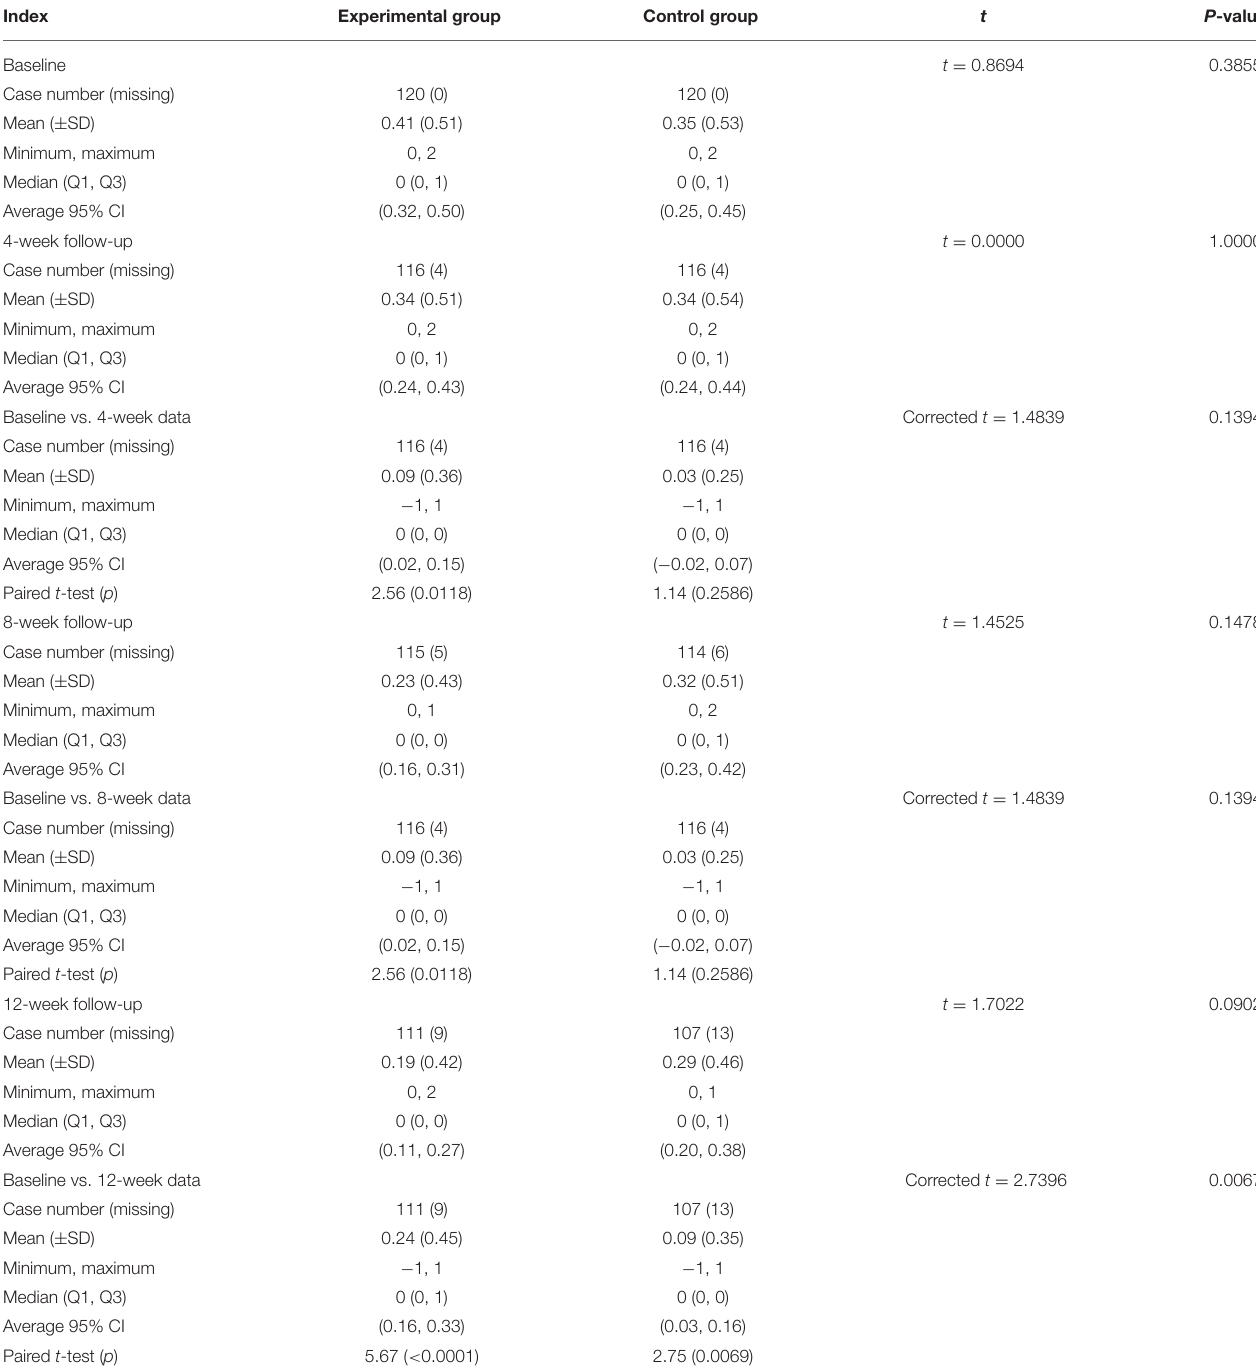
TABLE 10 | Comparison of nitroglycerin intake between the two groups